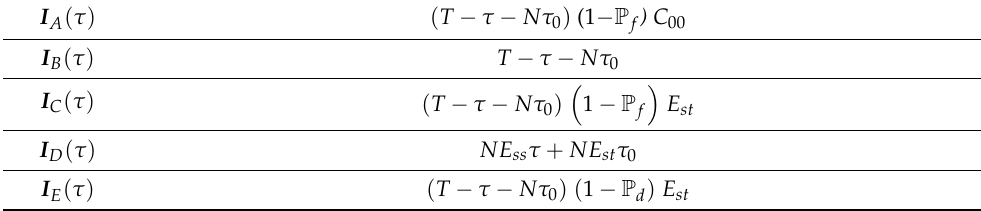
Table 2. Useful sub-functions of EE with τ as a